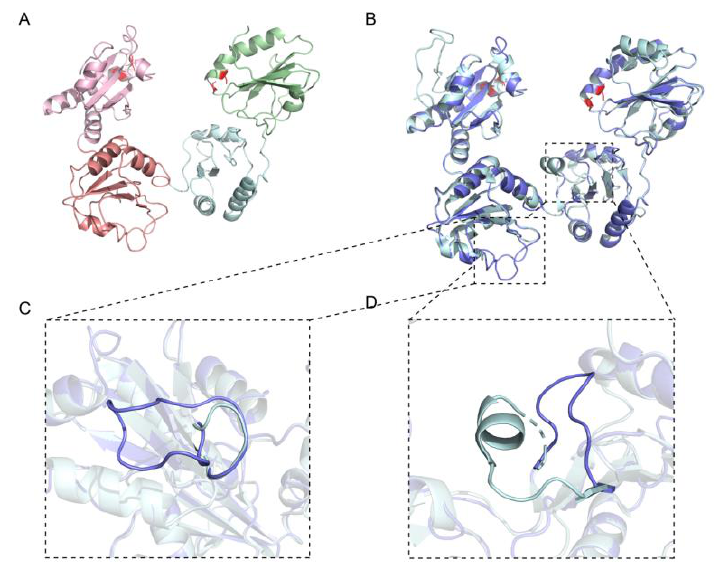
Figure 2. Simulated structure of wheat protein disulfide isomerase (wPDI). ( A ) the simulated structure of reduced wheat protein disulfide isomerase (wPDI R ) with the template of human protein disulfide isomerase (hPDI) (reduced, PDB ID 4ekz). Domain a, b, b′ and a′ are colored as light pink, salmon, pale blue and pale green, respectively. ( B ) the structural superposition of wPDI R with hPDI R . ( C , D ) the zoomed image of the extra loop structures in wPDI compared with hPDI.